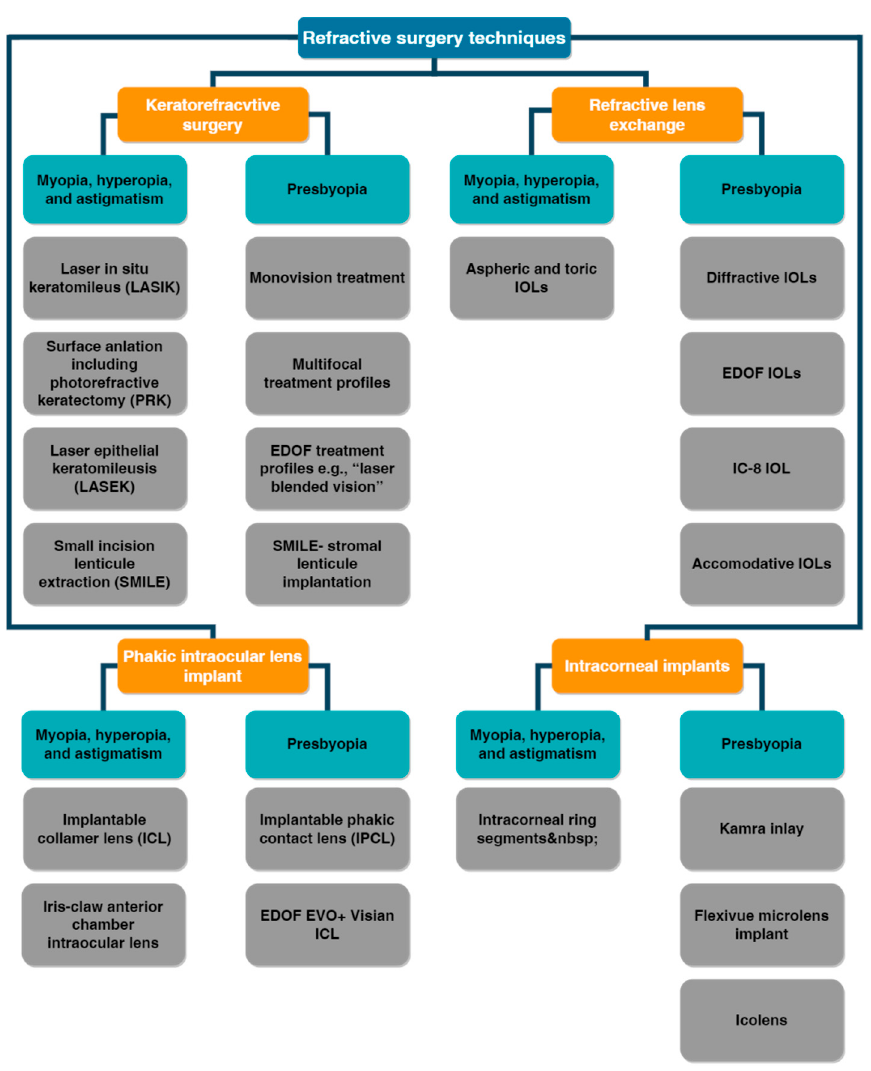
Figure 27. Scheme of refractive surgery techniques. For more details, see Ref. [137].